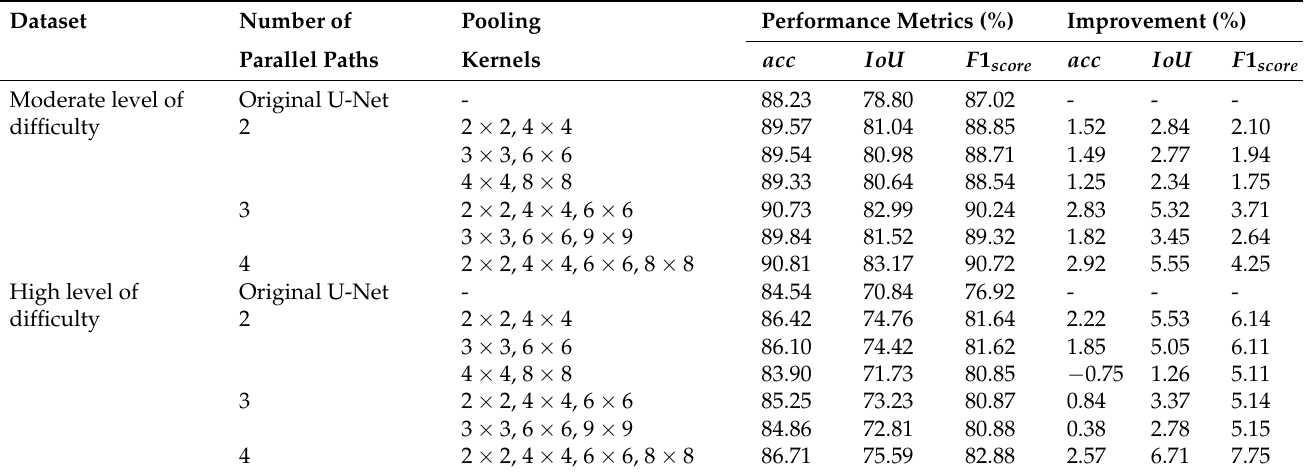
Table 7. Performance results of the U-Net with an embedded spatial pyramid pooling